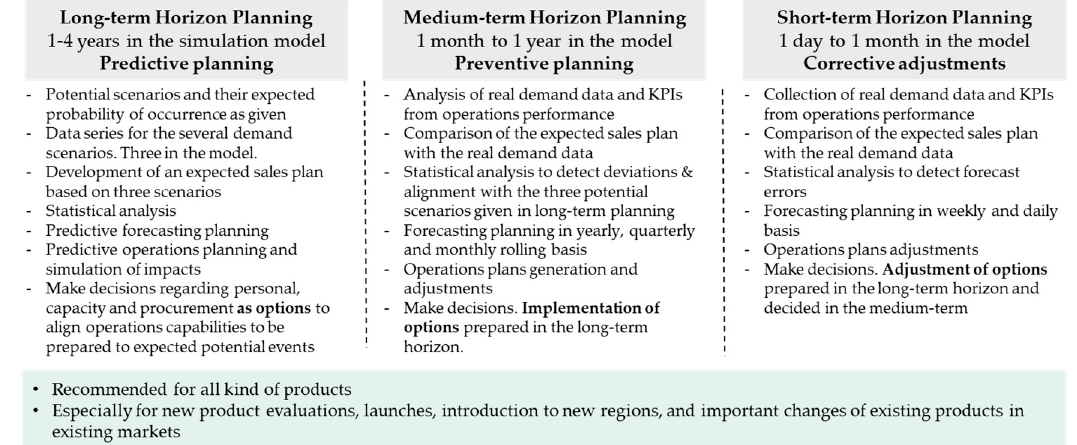
Figure 4. Planning based on the time horizon: predictive, preventive, and corrective (own elaboration).